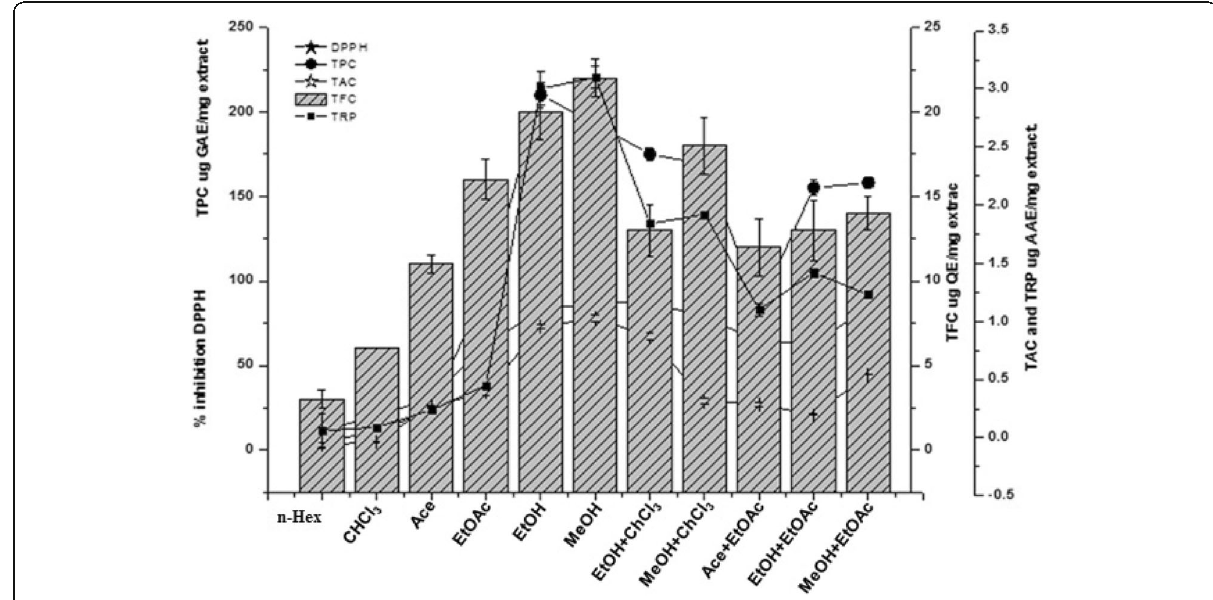
Fig. 1 Total phenolic, flavonoid contents and antioxidant activity of different non polar to polar solvent extracts of A.